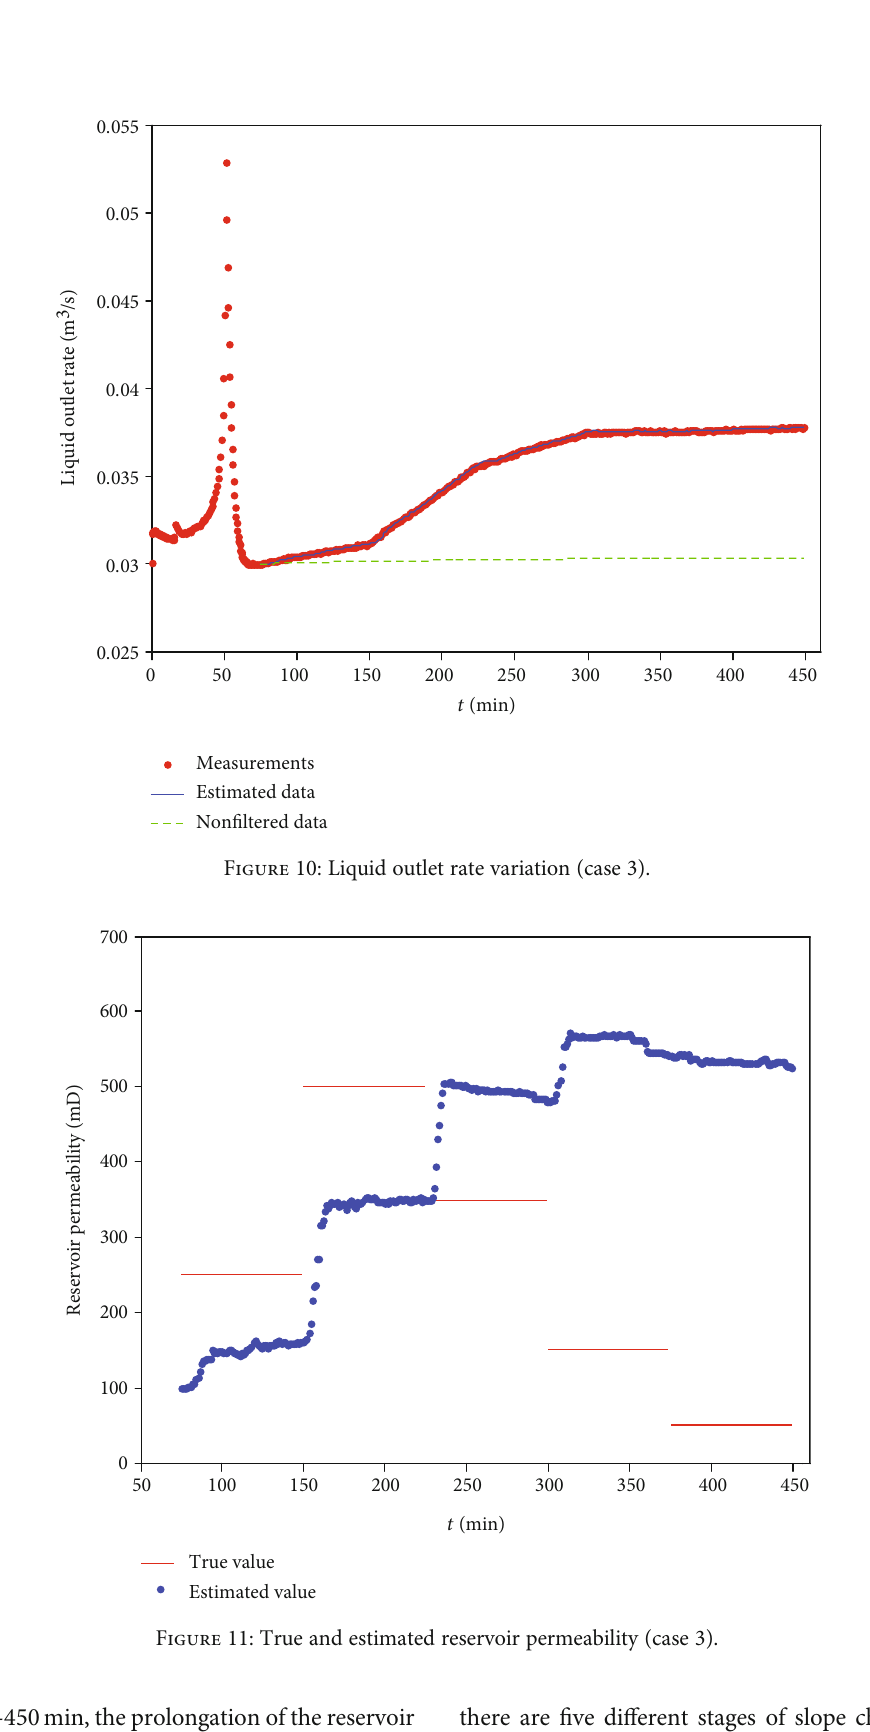
Figure 11: True and estimated reservoir permeability (case